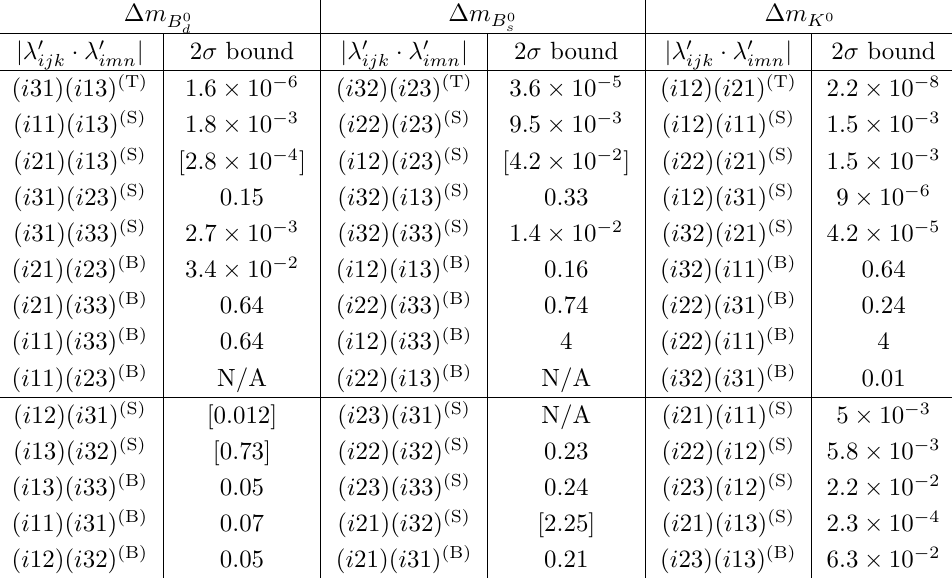
Table 2. Compilation of the latest bounds on relevant couplings of LQ (cid:22) D operators, coming